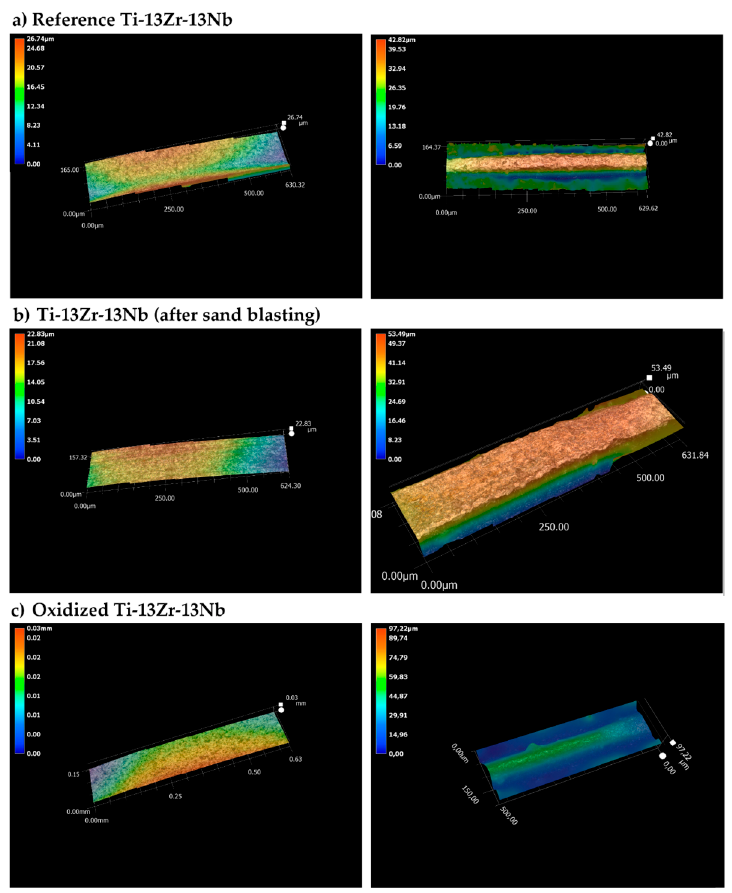
Table 3. Sa roughness parameters results.